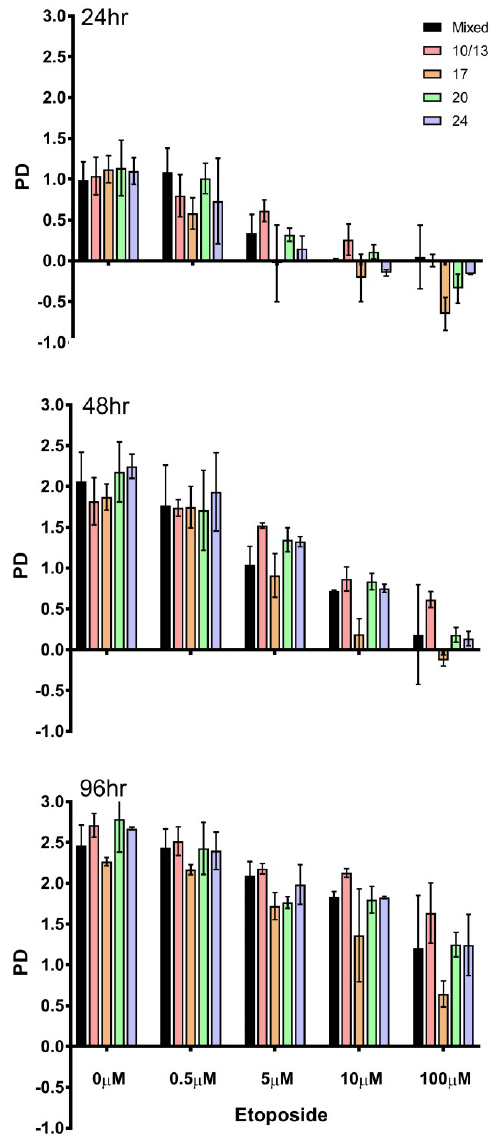
Figure 4. Drug sensitivity of the starting mixed population and the elutriated fractions. Cells from each elutriated fraction were treated with etoposide (0–100 μM) for 1 h. Cells were then replated in fresh medium and were counted after 24, 48 and 96 h. Population doublings were calculated according to the formula PD = Log 10 (cell count/initial cell count)/Log 10 (2). Data represent the mean ± SEM derived from duplicate elutriation